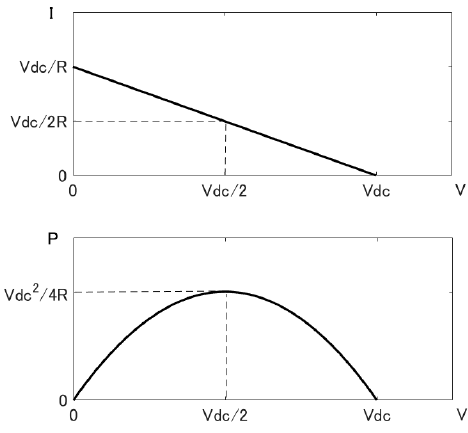
Figure 10. Voltage-current and voltage-power characteristic curves of the PV model.